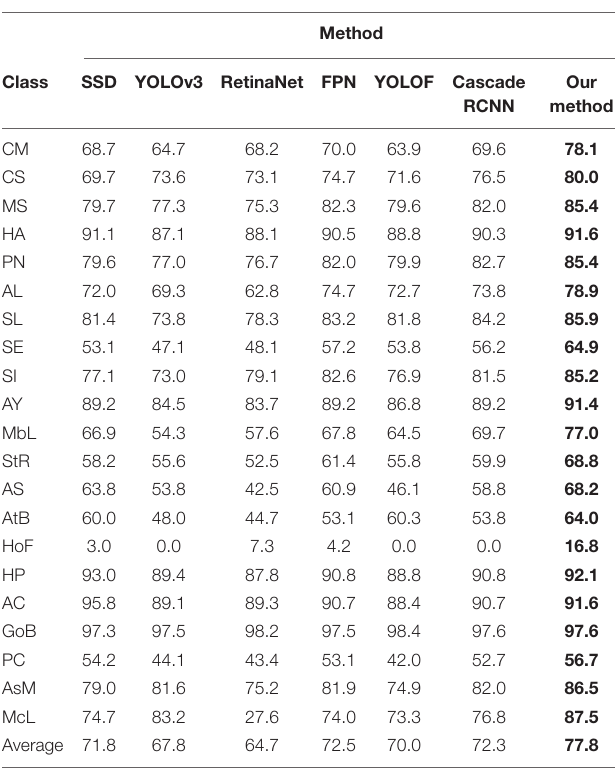
TABLE 4 | Detection results (AP) compared with other methods on pest dataset (unit: